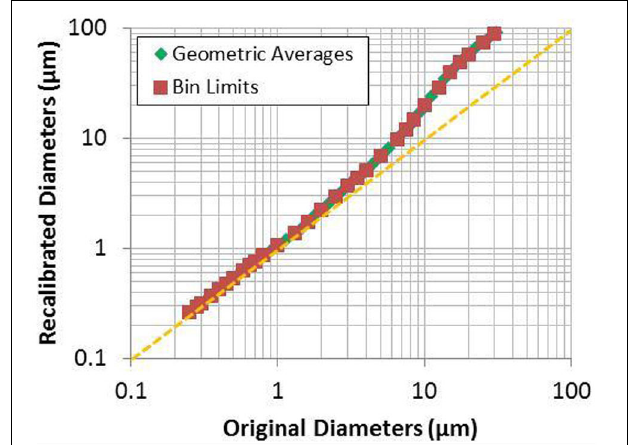
FIGURE 3 | Recalibration curve for GRIMM AOS diameters from original factory values, using Mie equation applied to the equipment geometry, for particles with a RI = 1 . 53-0.005i.